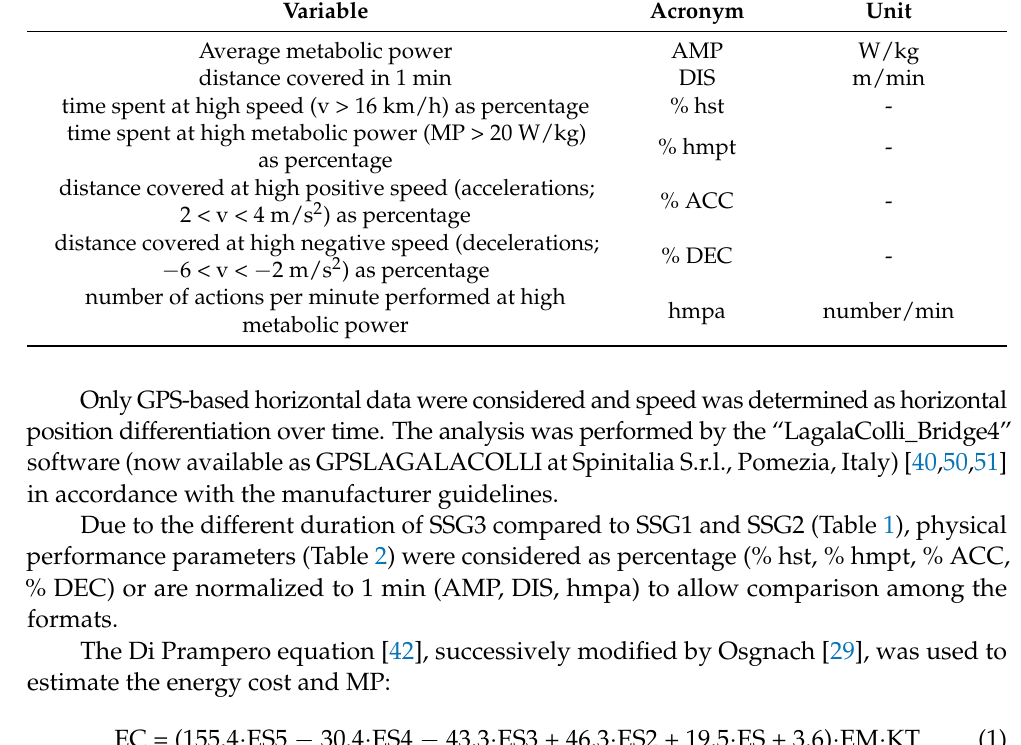
Table 2. Soccer-related performance variables analyzed in this study. Variable Acronym Unit Average metabolic power AMP W/kg distance covered in 1 min DIS m/min time spent at high speed (v > 16 km/h) as percentage % hst - time spent at high metabolic power (MP > 20 W/kg) % hmpt - as percentage distance covered at high positive speed (accelerations; % ACC - 2 < v < 4 m/s 2 ) as percentage distance covered at high negative speed (decelerations; % DEC - − 6 < v < − 2 m/s 2 ) as percentage number of actions per minute performed at high hmpa metabolic power